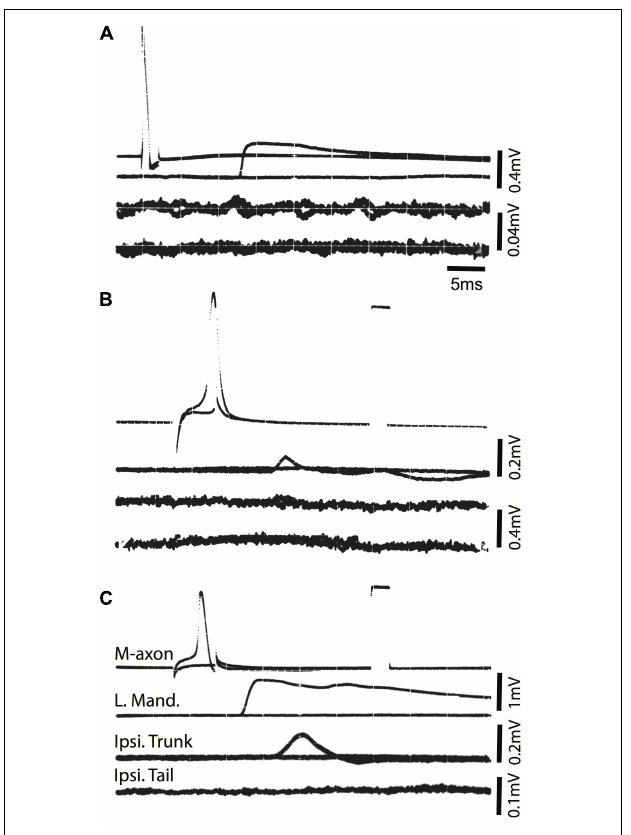
FIGURE 6 | Activation of the M-axon after spinal cord crush and the emergence of post-injury startle responses results in little or no EMG responses in trunk and no response in tail musculature. (A) Recordings made from a fish 2 days after SML crush to determine whether the injury severed the M-axons. Traces from top to bottom: (1) Intracellular recording from the M-axon above and below threshold, (2) EMG recording from the left mandibular muscle, (3) EMG recording from the trunk musculature ipsilateral to the M-axon and (4) EMG recording from the tail musculature ipsilateral to the M-axon. The activation of an M-axon resulted in left mandibular EMGs but no response in the ipsilateral trunk or tail musculature. (B) An M-axon action potential resulted in a left mandibular EMG but no trunk or tail EMGs 206 days postoperatively. (C) An M-axon action potential resulted in a left mandibular EMG and a small EMG in the trunk but not tail musculature 213 days postoperatively. a left mandibular EMG but no response in the ipsilateral trunk or tail musculature.